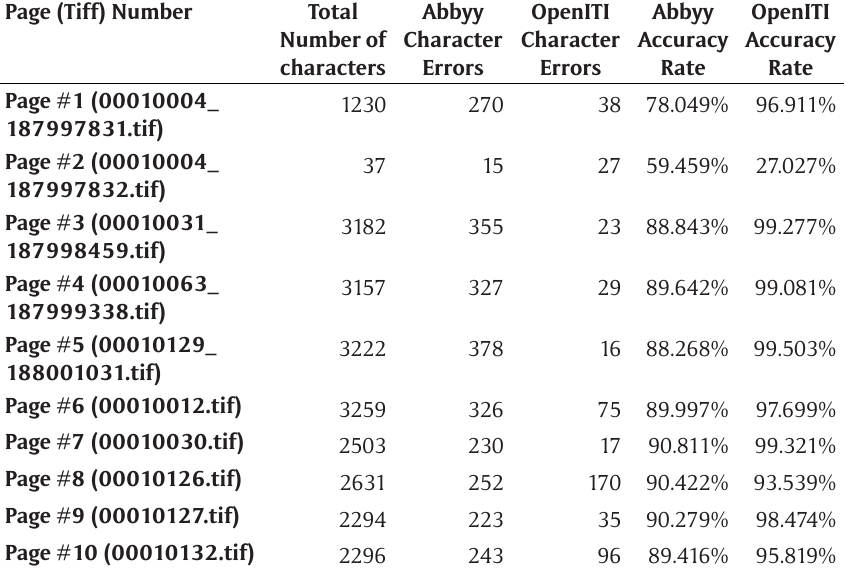
Table 1: Contractor’s Accuracy Comparison of Abbyy and OpenITI (Kraken) OCR